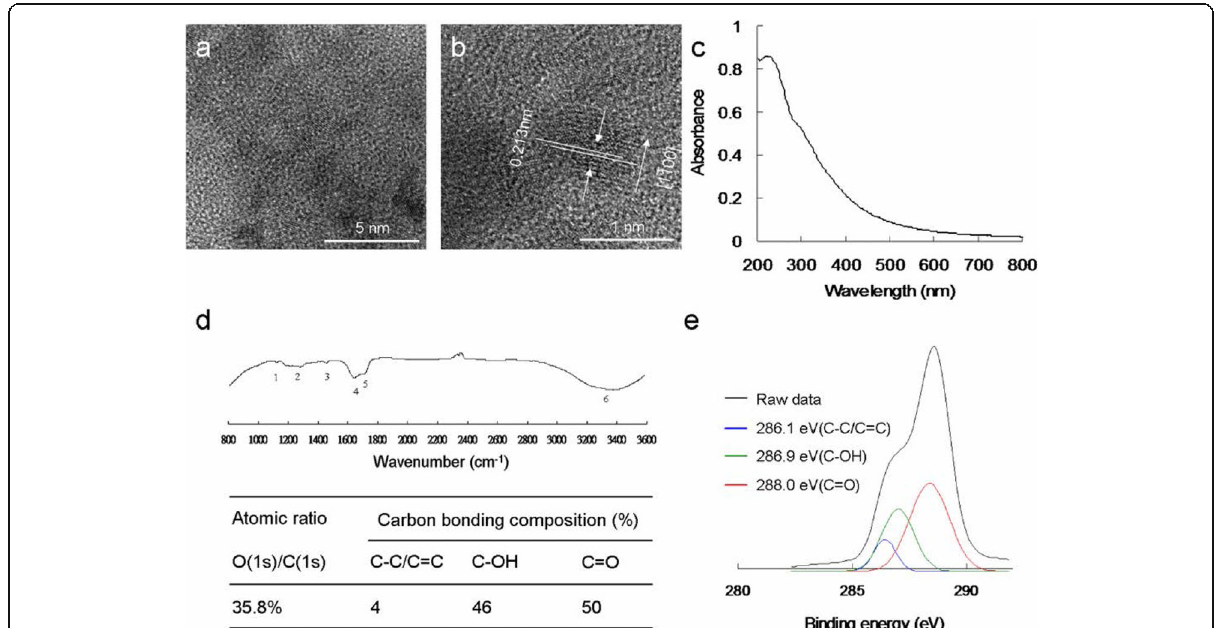
Fig. 2 Functional characterization of the synthesized water-soluble C 60 (OH) 46 fullerenol. a Low-magnified TEM image and b HR-TEM image of a water-soluble fullerenol illustrating the materials {1 (cid:1) 100} lattice planes and the mean size of 1.11 ± 0.03 nm with a d -spacing of 0.213 nm. c UV – vis and d FTIR spectra of nanomaterial. e Deconvoluted C(1s) XPS spectra and fitted peaks obtained using Gaussian function: nonoxygenated ring (C – C/C=C), C – O bond, and C=O bond, respectively. The atomic ratio and bonding composition of fullerenol are shown as summarized in the table. The O(1s)/C(1s) atomic ratio is